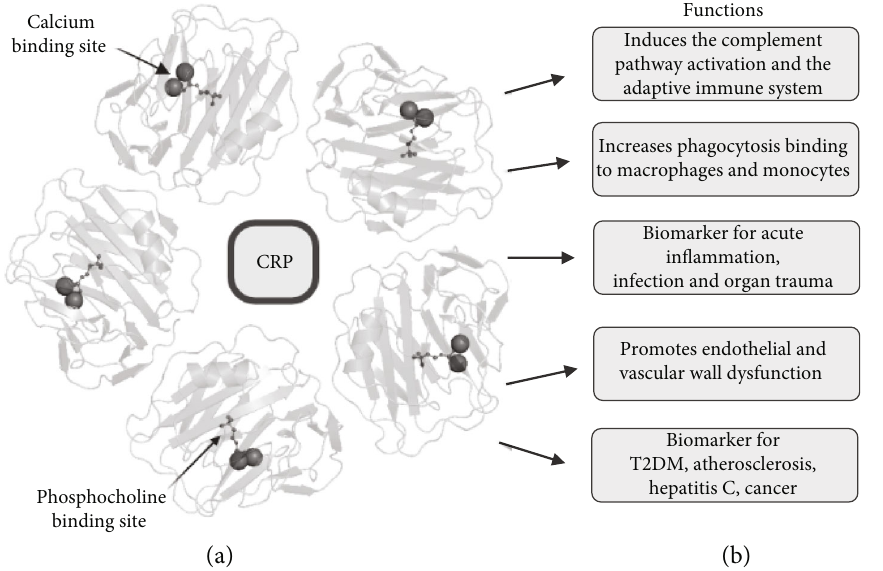
Figure 1: (a) C-reactive protein (CRP) crystal pentametric structure with calcium and phosphocholine binding sites. (b) Functions of CRP. CRP: C-reactive protein. Biorender.com and Protein Data Bank in Europe were used to generate the ribbon diagram of the CRP